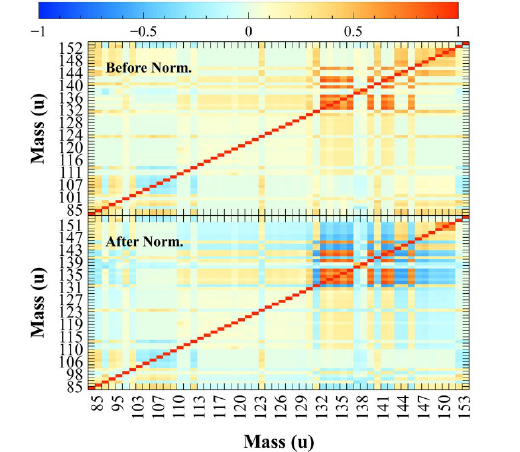
Fig. 3. Mass yield correlation matrix from CEA (2015) [10, 11] considering the uncertainties of Brosa’s fission mode parameters and the prompt neutron yield uncertainties (saw tooth).